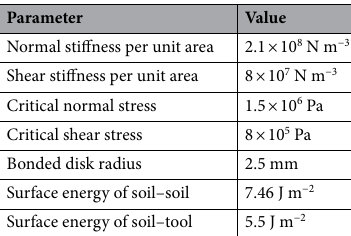
Table 2. Parameters of contact